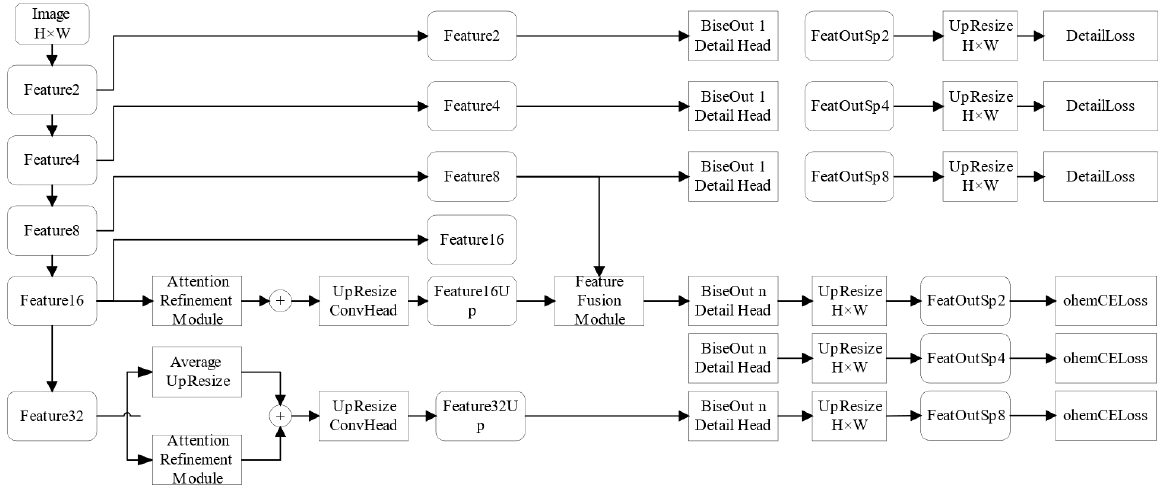
Figure 5. STDC Network.